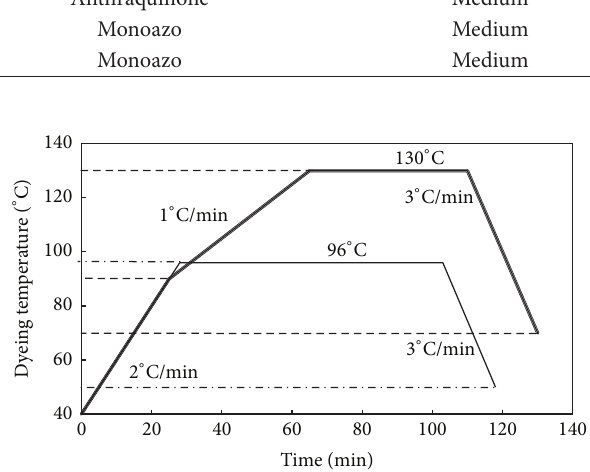
Figure 1: Dyeing profiles at boiling ( ≈ 100 ∘ C) and 130 ∘